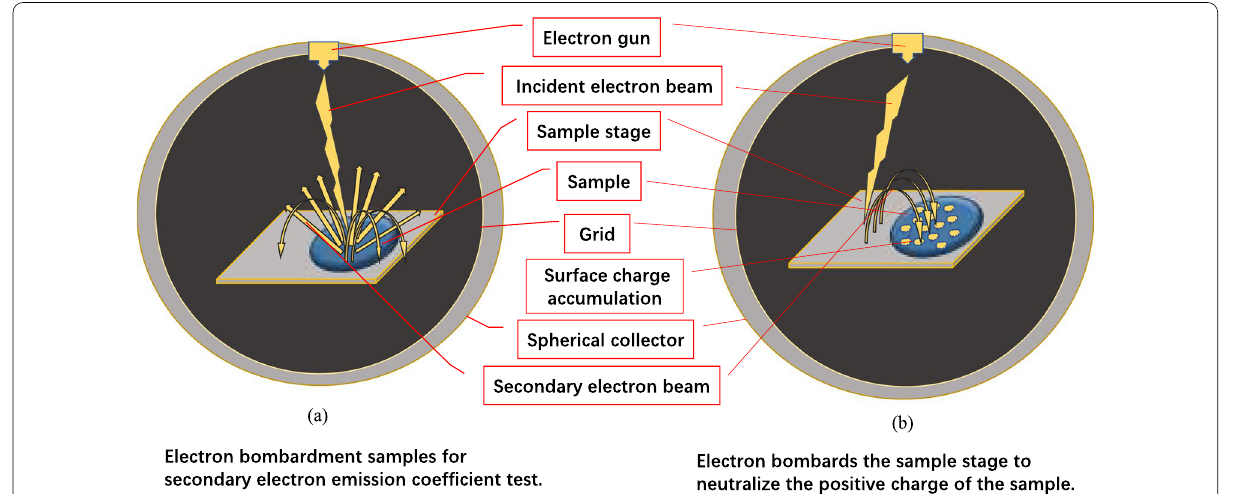
Fig.5 Schematic diagram of the new test method for the secondary electron emission coefficient of the